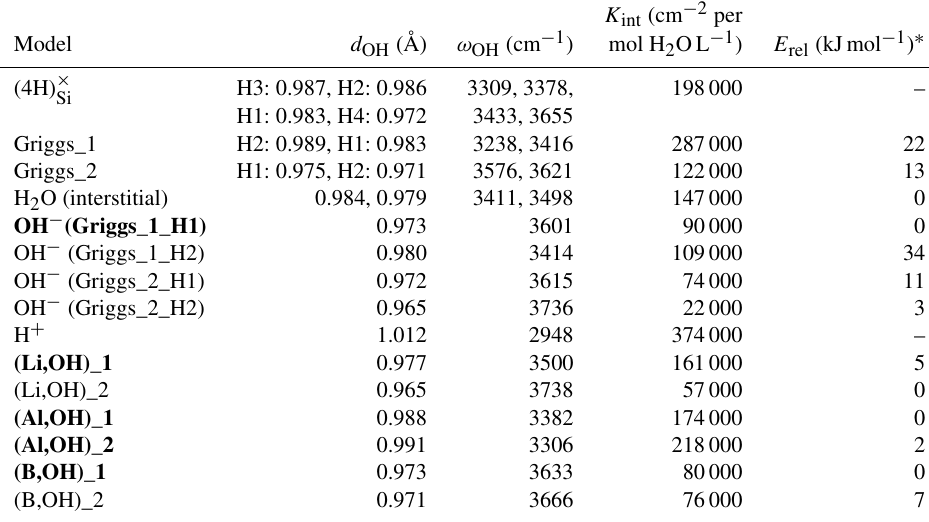
Table 1. Properties of OH-bearing defect models: OH bond length ( d OH ), stretching frequency ( ω OH ), integrated molar absorption coefficient ( K int ) and relative energy ( E rel ). Models that best match the properties of experimentally observed bands are in bold type. K int (cm − 2 per